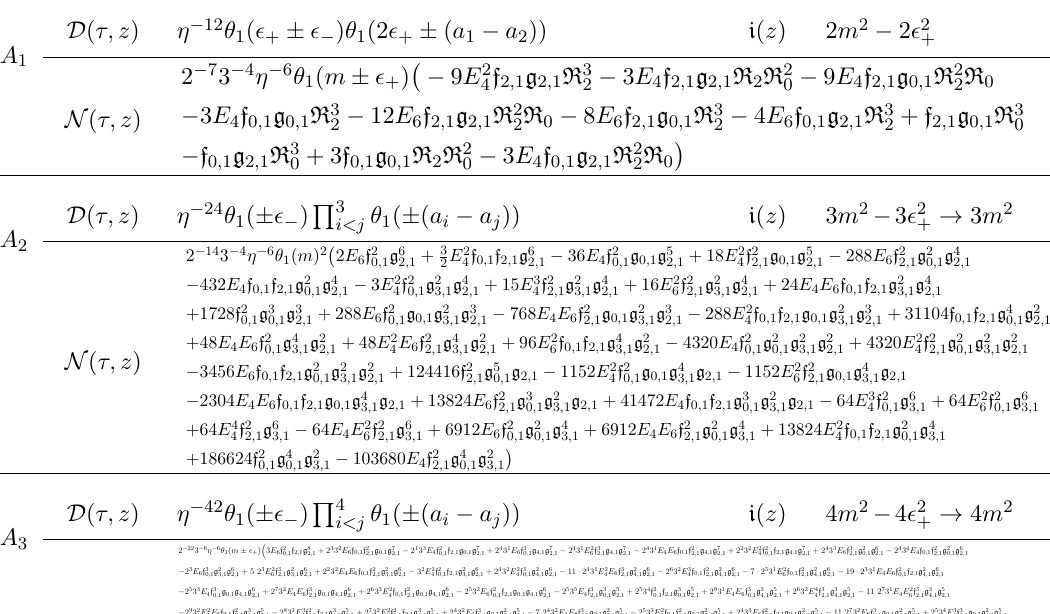
Table 3 . Elliptic genera of (1 ; 1) little strings determined from I